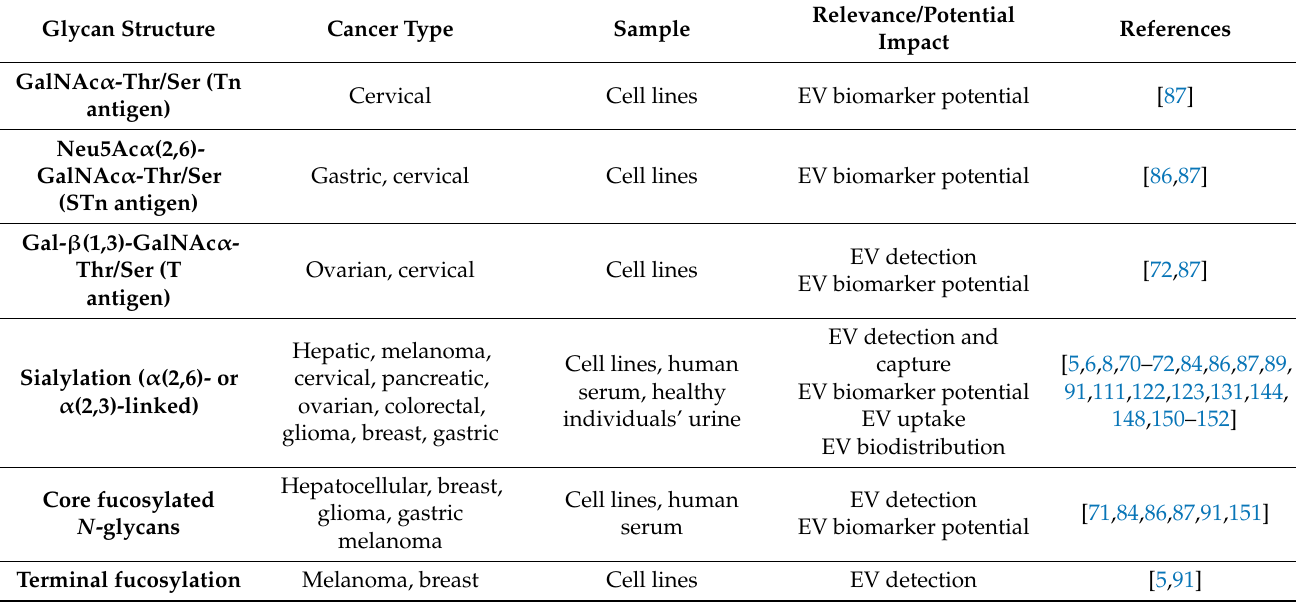
Table 1. List of the main structures of glycans identified in different cancer extracellular vesicles (EVs) samples and their relevance and potential impact in the EV